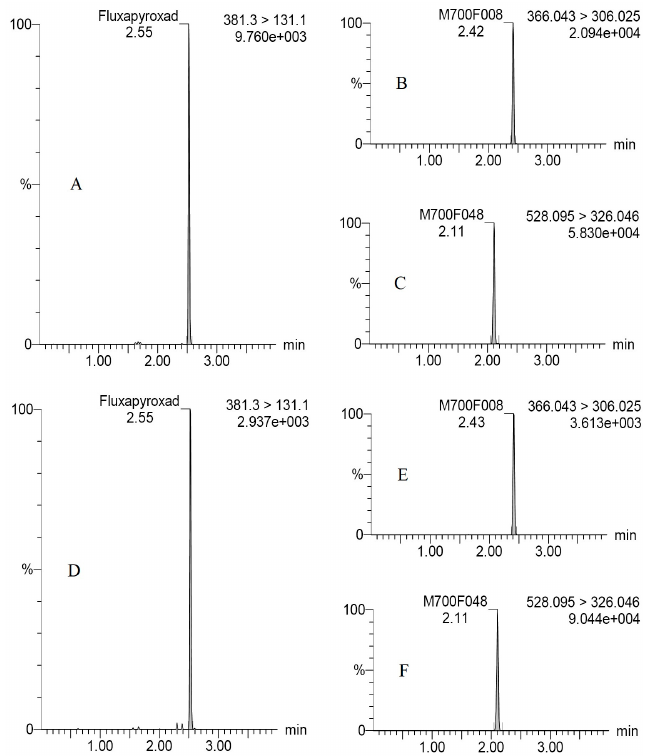
Figure 1. Typical UHPLC–MS/MS (MRM) chromatograms of fluxapyroxad, M700F008, and M700F048 in 0.05 mg/L of matric–matched standard solution ( A – C ) and peanut straw at 21 days in Trial #3 ( D – F Table 1 . Linear regression parameters and recoveries for the fluxapyroxad, M700F008 and M70F048 in different matrices .